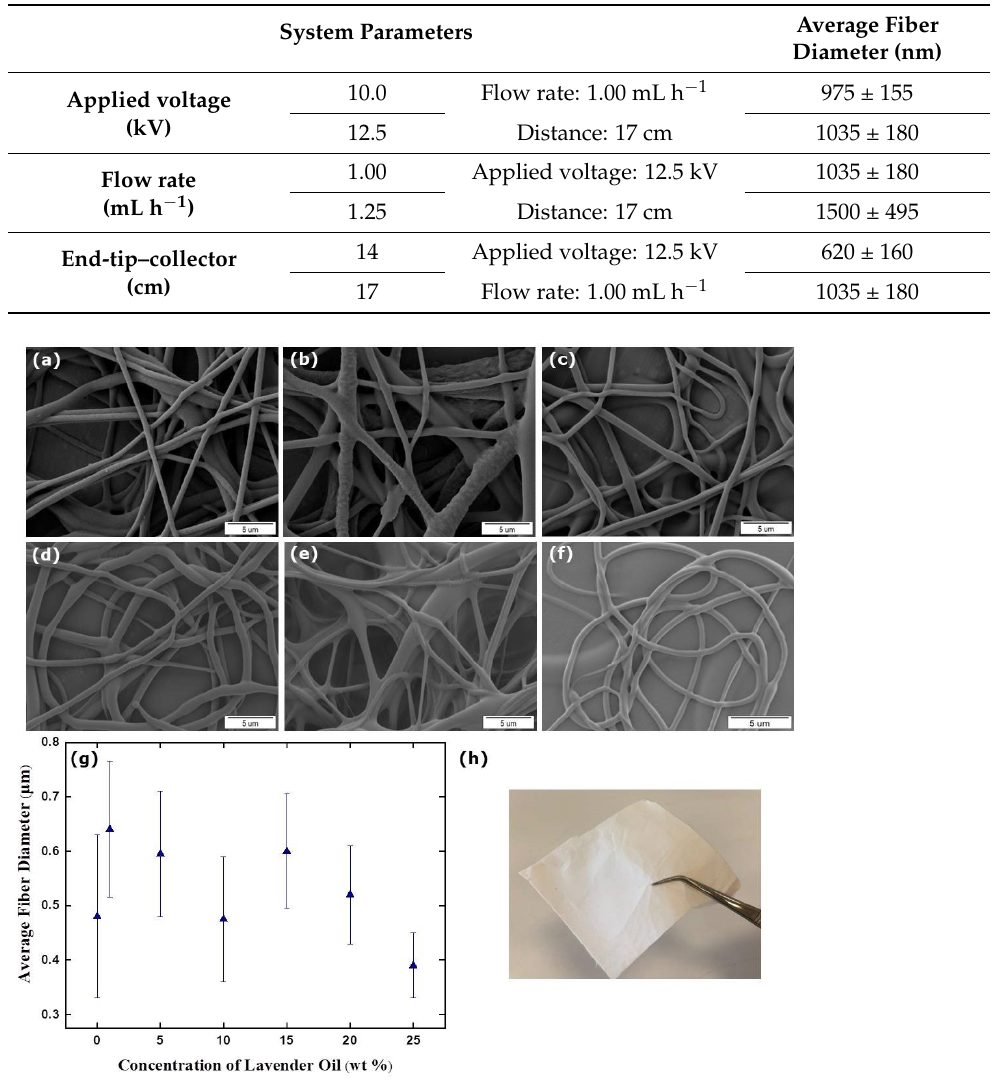
Figure 4. SEM micrographs with different concentrations of LO: ( a ) 1 wt %, ( b ) 5 wt %, ( c ) 10 wt %, ( d ) 15 wt %, ( e ) 20 wt %, ( f ) 25 wt %, the diameter distribution histogram ( g ), and photograph ( h ) of the TPU/LO fibers (applied voltage: 12.5 kV, flow rate: 1.00 mL h − 1 , distance: 17 cm, and TPU concentration in TPU/LO fibers: 12.5 wt